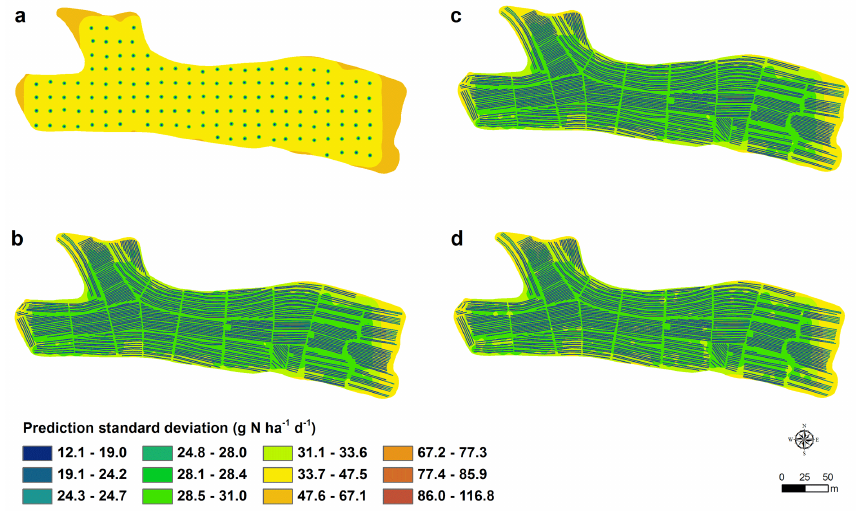
Figure 10. Spatial distributions of kriging standard deviations of the predicted N 2 O fluxes by (a) OK, (b) RK, (c) CK with SOCt as the covariable, and (d) CK with NH4Nt and NO3Nt as two